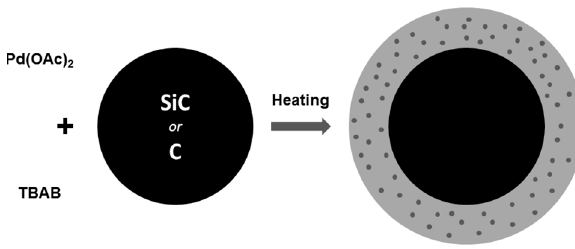
Figure 3. Preparation of Pd@TBAB@(Si)C.